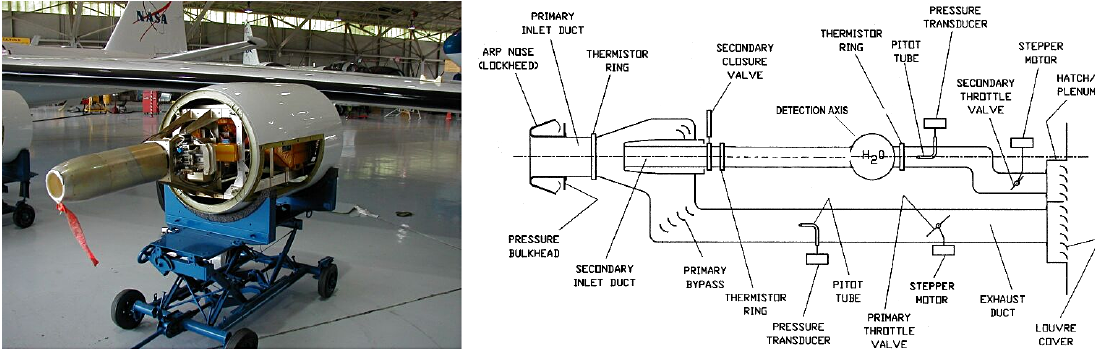
Figure A5. Left: the HWV instrument as it is mounted in the WB57F. Right: schematic illustrating the subsystems that control the flow of air through the instrument and acquire simultaneous measurements of temperature, pressure, and velocity in the duct.